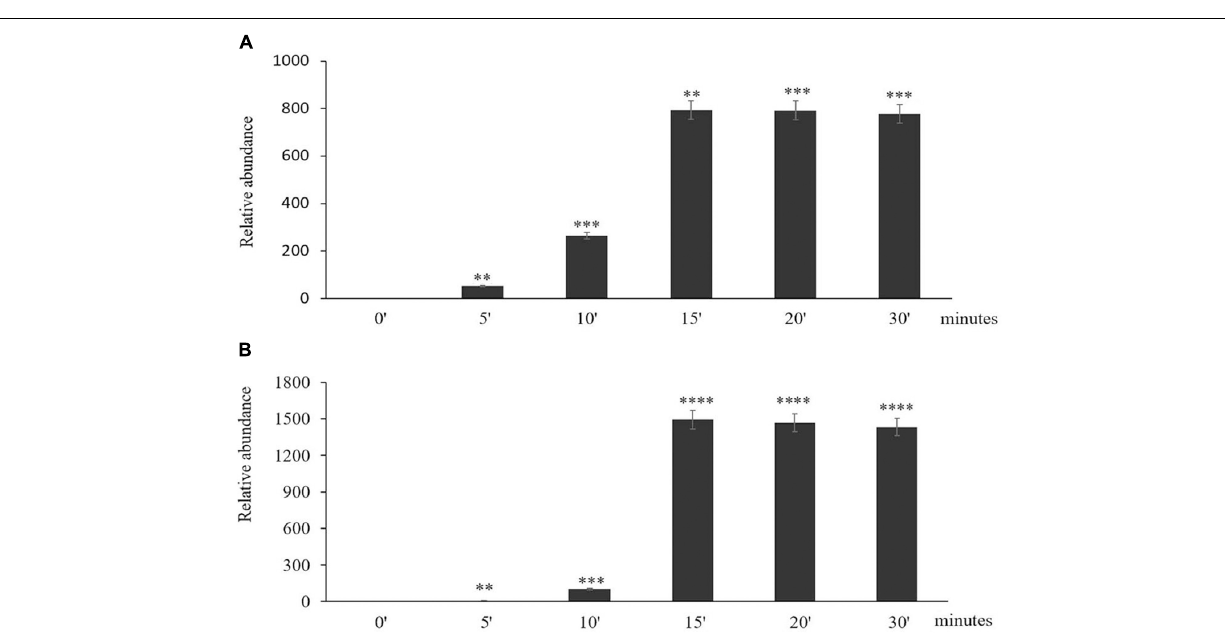
Frontiers in Plant Science |